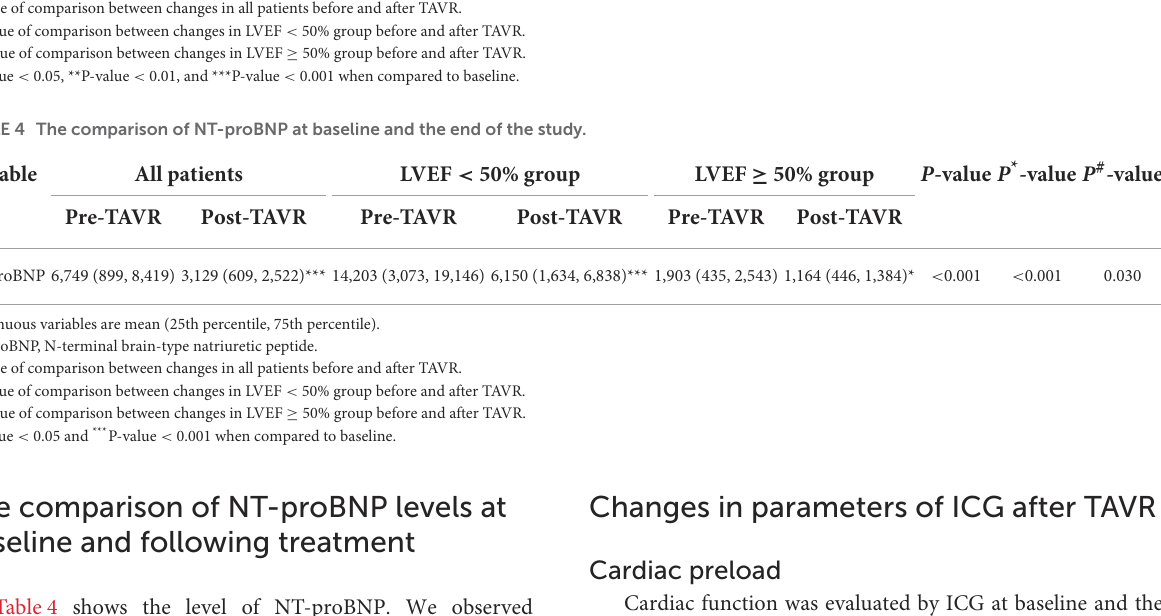
Cardiac function was evaluated by ICG at baseline and the end of 1 week after TAVR. No difference was found in the Table 6). After sub-dividing subjects into high-TFC group (TFC